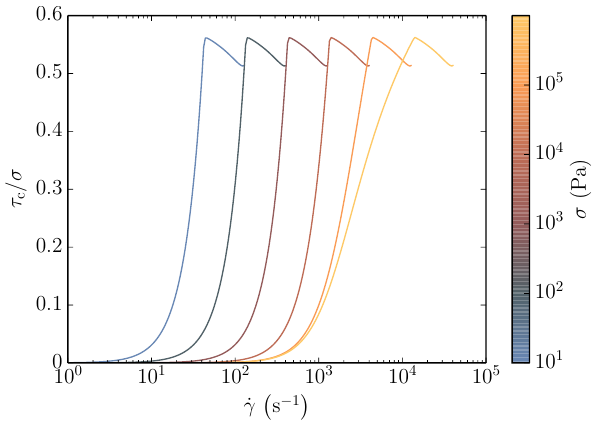
Figure 7. Contribution of collisions: stress ratio τ c /σ